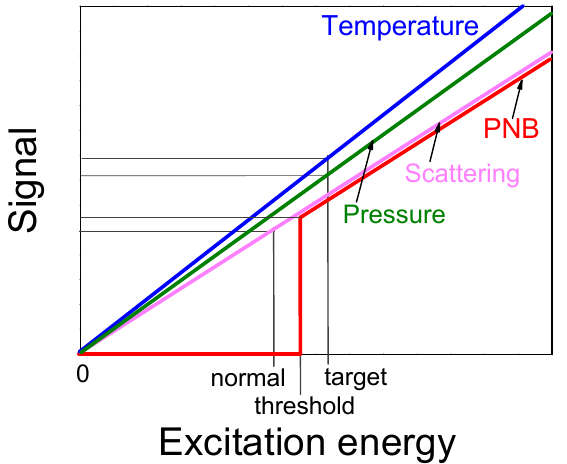
Figure 13. Signals from the two different cell, normal cell (NP cluster-negative) and target cell (NP cluster-positive) generated by several non-threshold (thermal, acoustical, optical) and threshold (PNB) optical processes as function of the excitation energy. In case of the threshold process the normal cell returns zero signal (no bubble) thus providing maximal contrast and selectivity relative to a target